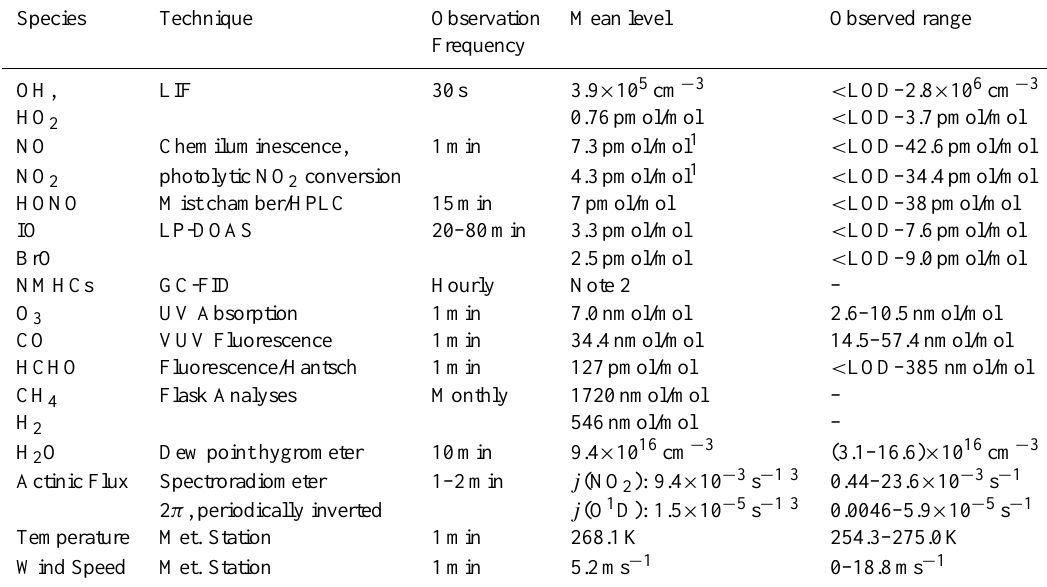
Table 1. Observed chemical climatology of the Coastal Antarctic Boundary Layer during the CHABLIS summer measurement period (January–February